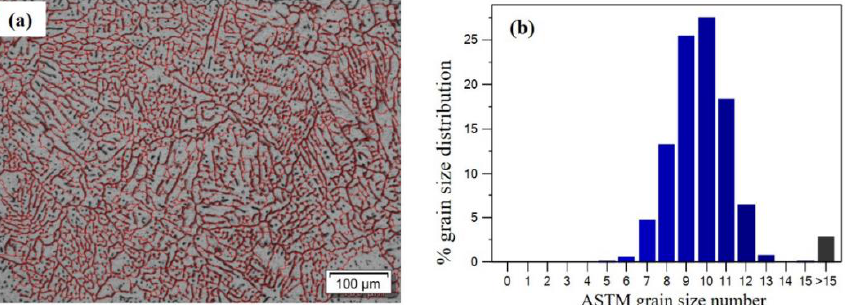
Figure 9. ( a ) Microstructure of FZ with grain boundary selection in image analysis software; ( b ) % grain size distribution versus grain size number in the FZ.